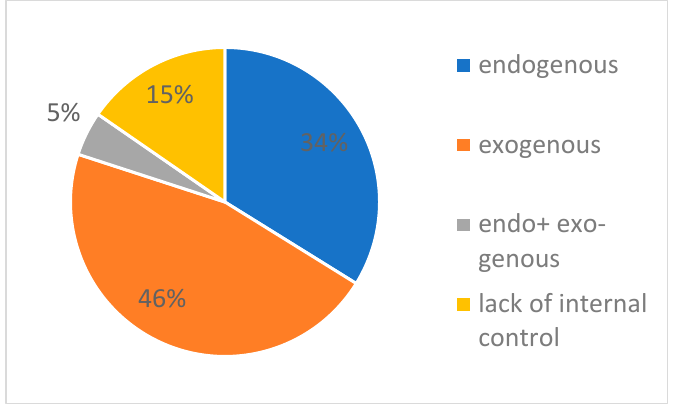
Figure 1. The type of internal control used in PCR tests for SARS-CoV-2 available in Poland. 4. What Genes Are Analyzed in PCR for the Detection of SARS-CoV-2?